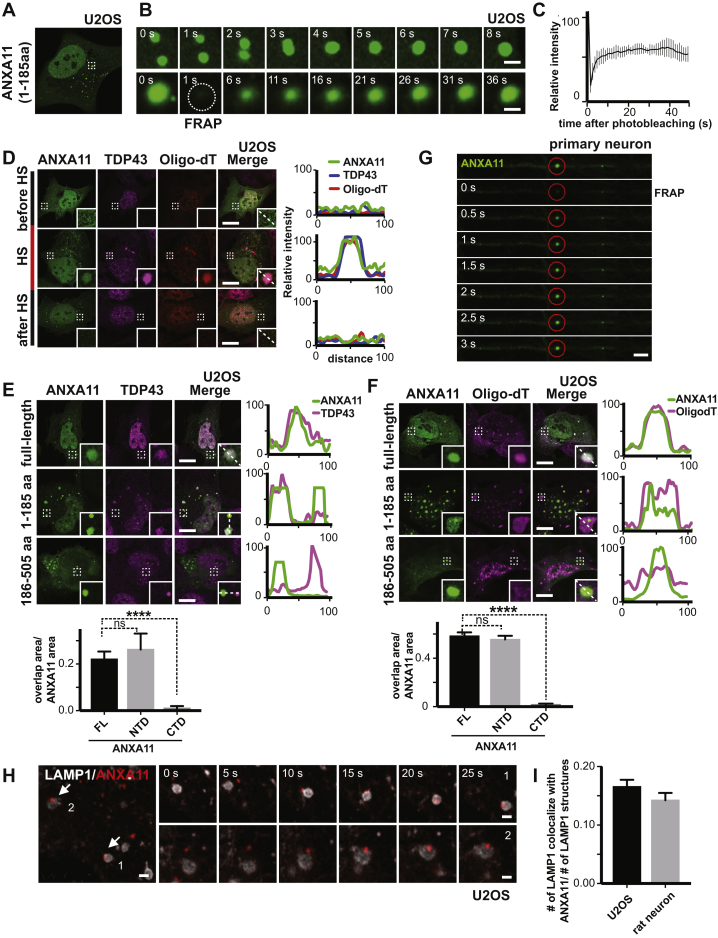
ANXA11 Exhibits Phase Condensate Properties and Interacts with Both RNA Granules and Lysosomes in Living Cells, Related to Figure 3(A) ANXA11’s amino acid sequence 1-185 was tagged with mEmerald and expressed in U2OS cells. Small ANXA11 positive puncta appeared in cells that had not been heat shocked.(B) Live cell imaging of puncta from (A) reveal these structures are motile and undergo fusion (upper panel). Upon photobleaching, ANXA11 fluorescence within the puncta quickly returned from free cytoplasmic pools (bottom panel). Scale bar: 1 μm.(C) Quantification of the FRAP experiment in (B), n=7.(D) Co-localization of ANXA11 puncta with RNA granule markers before, during and after heat shock (HS). U2OS cells under normal culture conditions (before HS), under heat shock (HS) or 4 hours after heat shock (after HS) were fixed, hybridized with Cy3-Oligo dT(30) followed by immunostaining with antibody against TDP43. Linescans show the related intensity profiles of ANXA11 with mRNA (Cy3 Oligo-dT) and with TDP43. Scale bar: 30 μm.(E) Co-localization of ANXA11 full-length, N-terminal or C-terminal domain with RNA granules. U2OS cells were fixed after 30 minutes of heat shock (43oC), followed by immunostaining with antibody against TDP43. Line scans show the related intensity profiles of ANXA11 with TDP43. Scale bar: 30 μm. One-way ANOVA, ∗∗∗∗p < 0.0001, n=20 (FL), 11(NTD), 19(CTD), Error bars=SEM.(F) Co-localization of ANXA11 full-length, N-terminal or C-terminal domain with RNA granule. U2OS cells were fixed after 30 minutes of heat shock (43oC), followed by hybridizing with Cy3-Oligo dT(30). Linescans show the related intensity profiles of ANXA11 with TDP43. Scale bar: 30 μm. One-way ANOVA, ∗∗∗∗p < 0.0001, n=30 (FL), 30(NTD), 27(CTD), Error bars=SEM.(G) Rat cortical neurons were transduced with ANXA11-mEmerald. A single labeled ANXA11 puncta was photobleached, then the recovery of fluorescence into the bleached region-of-interest was examined over time. Scale bar: 2 μm.(H) Time-lapse imaging showing the interaction of ANXA11 puncta (red) with LAMP1-labeled lysosomes (white) in U2OS cells after heat-shock. Scale bar: 1 μm.(I) Quantification of LAMP1 labeled lysosomes co-localizing with ANXA11(relative to number of lysosomes) in U2OS or rat neuron. N=25(U2OS), 10(neuron).